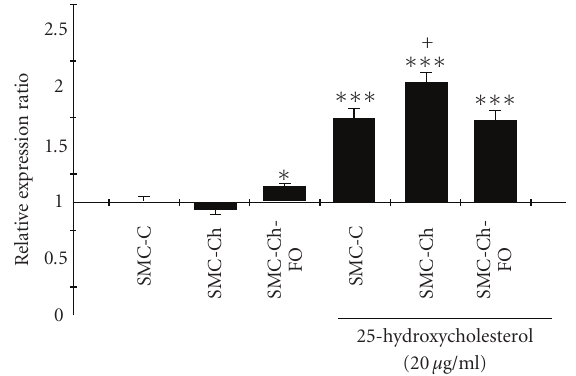
Figure 3: bcl-2 mRNA quantification in SMC cultures (SMC-C, SMC-Ch, SMC-Ch-FO) and SMC cultures treated with 20 μ g/mL 25-hydroxycholesterol for 24 hours. mRNA levels were quantified by real-time semiquantitative reverse-transcription PCR. Results are shown as relative expression ratio of bcl-2 in SMC cultures with respect to control culture and expressed in comparison to reference gene β -actin. Bars represent the means ± SEM for 3 di ff erent experiments. ∗ P < . 05, ∗∗ P < . 01, ∗∗∗ P < . 001 versus SMC-C, + P < . 05, ++ P < . 01, +++ P < . 001 versus SMC-C treated with 20 μ g/mL 25-hydroxycholesterol.